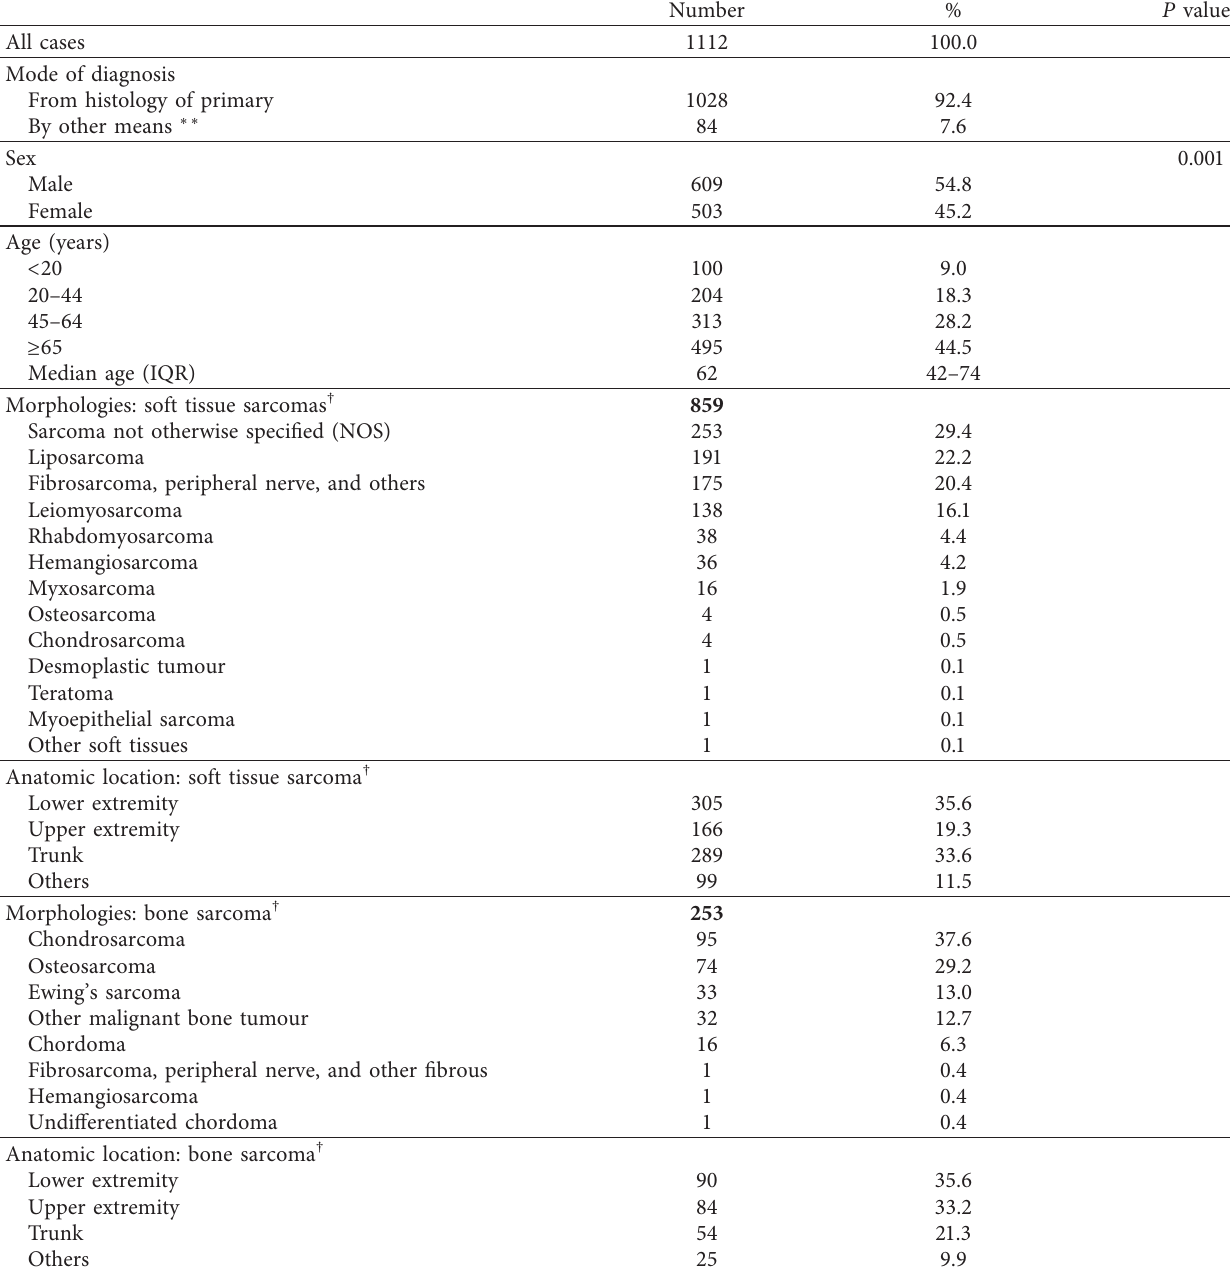
Table 1: Characteristics of soft tissue and bone sarcoma cases diagnosed in 2009–2012 and archived in 15 Italian population-based cancer registries affiliated to